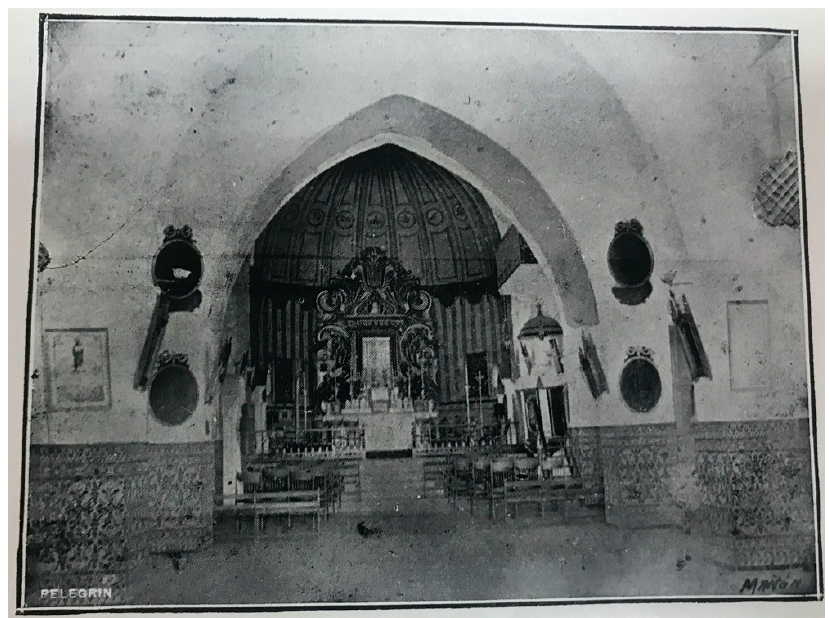
Figure 2. A view of the main altar in the San Dionisio sanctuary, with Altagracia medallions displayed, c. 1923. Album de la coronación. Used with permission from Archivo Histórico Diocesano de Santo Domingo.